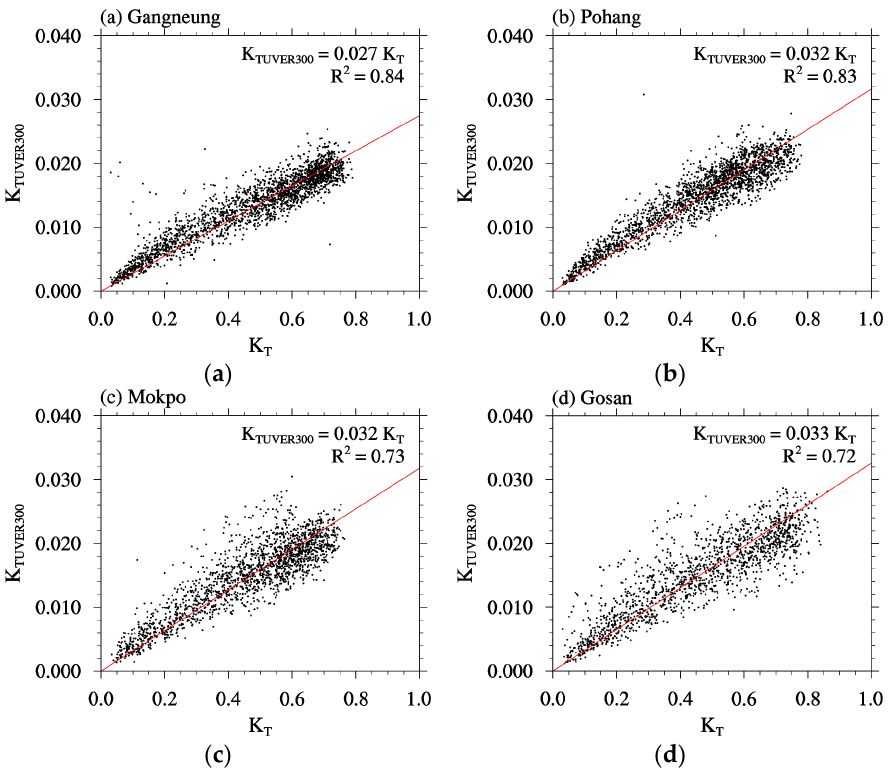
Figure 5. Relationship between K TUVER300 and K T at ( a ) Gangneung, ( b ) Pohang, ( c ) Mokpo, and ( d ) Gosan. The red line is the linear regression line.